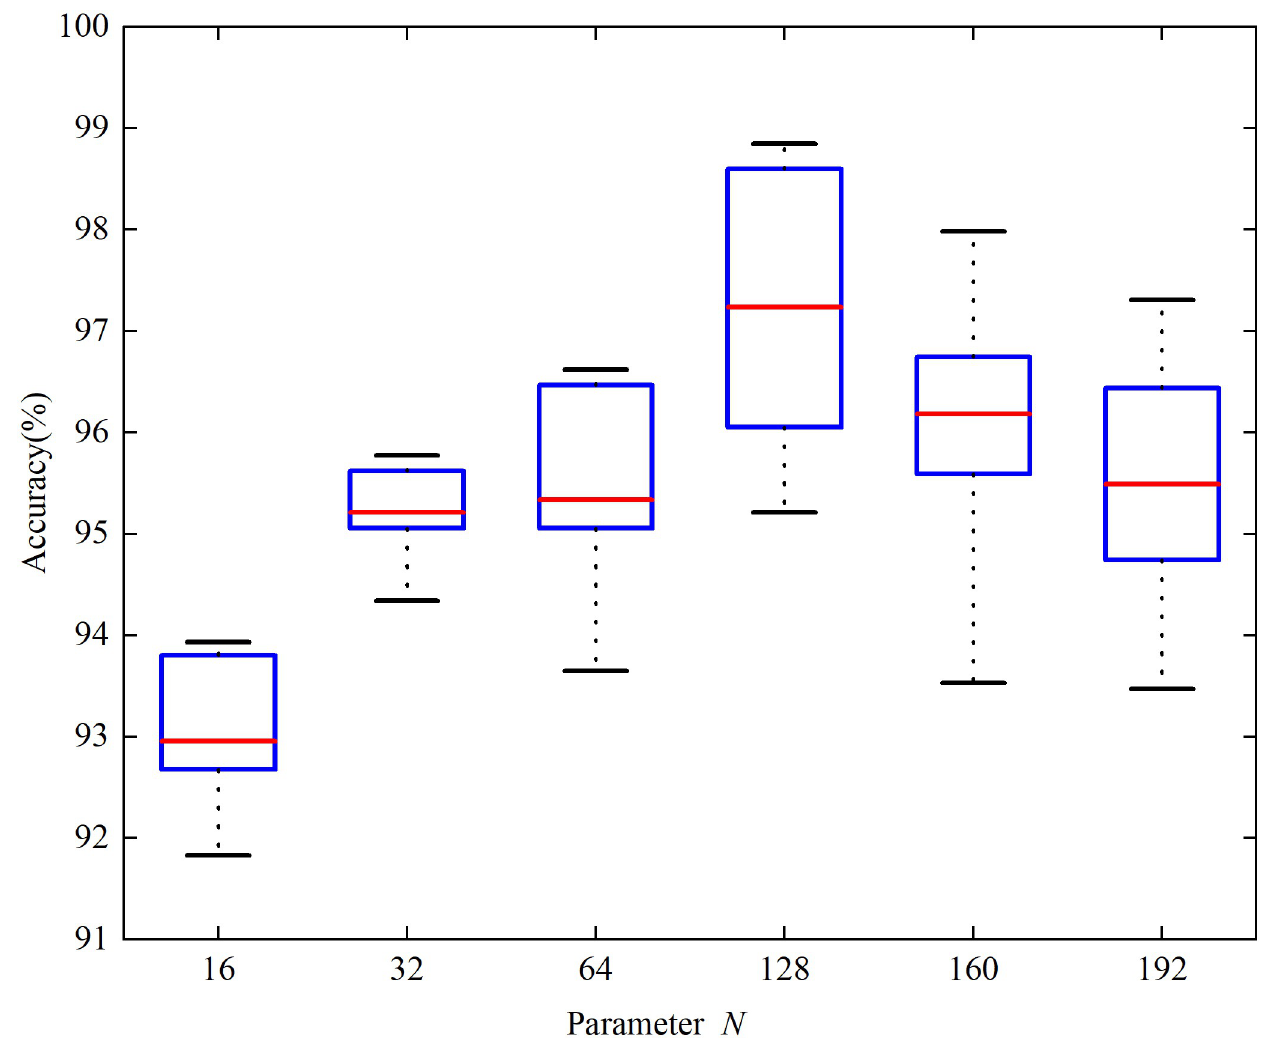
Fig 11. The selection of parameter N